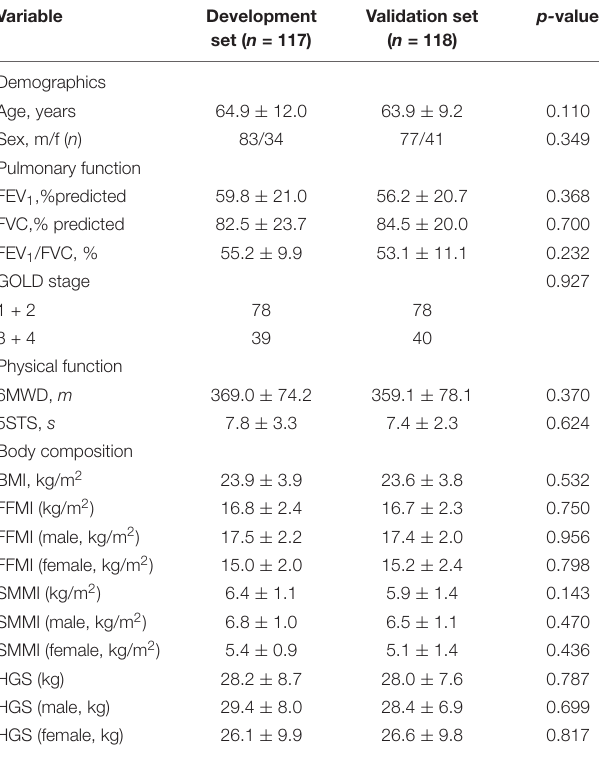
TABLE 1 | Baseline characteristics of subjects. TABLE 2 | Patient characteristics of the development set and validation